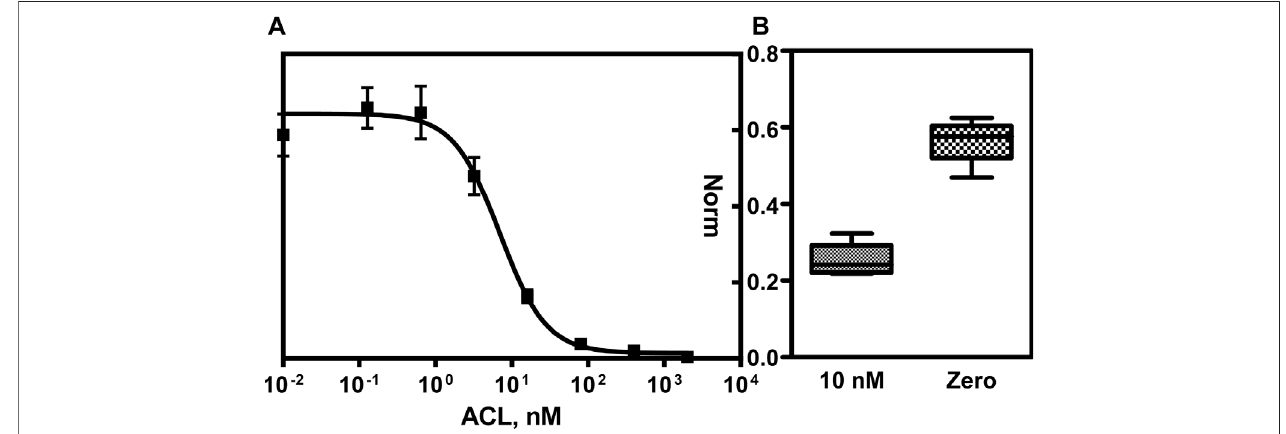
FIGURE 1 | (A) Normalized calibration curve for A2BSA/As233 combination using as IS, 13BS/As138 assay. The SD corresponds to the mean value of eight assays performed in different days. (B) Box plot obtained from two samples (Zero: non-spiked and spiked at 10 nM in PBST) measured in separate wells. The SD corresponds to the mean value of four assays performed in different days.